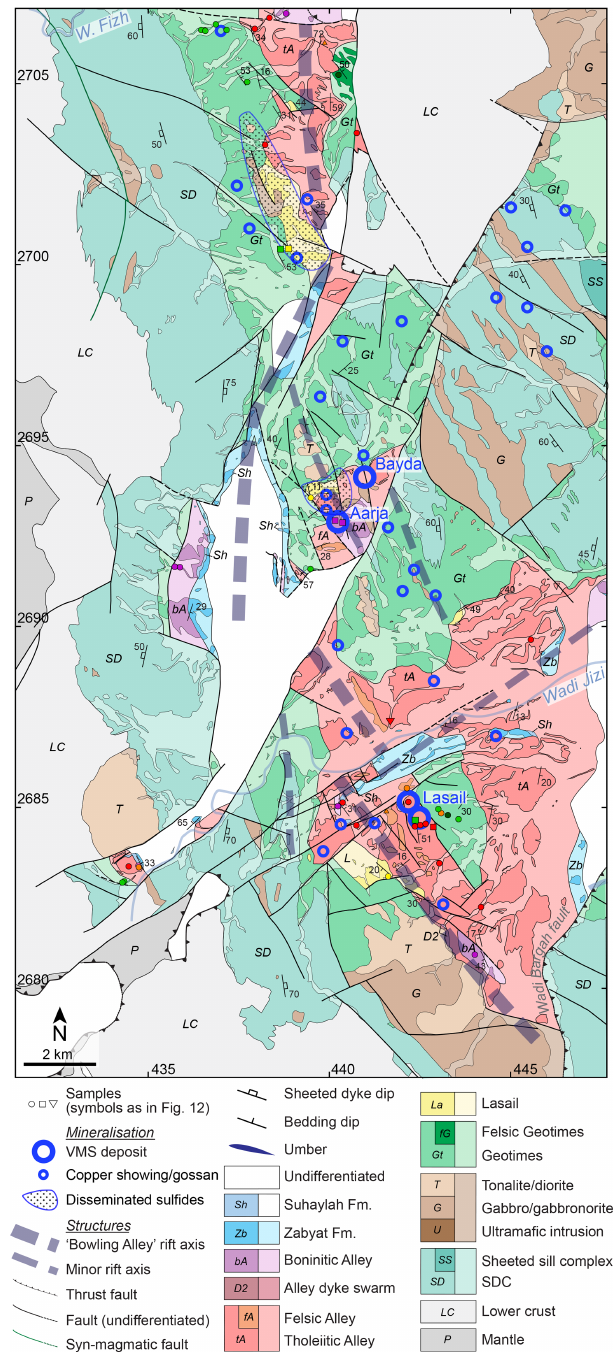
Figure 17. Interpreted location of the “Bowling Alley” rift, mod- ified after Alabaster and Pearce (1985), BME (1987a), Robertson and Woodcock (1983), and Smewing et al. (1977). The rift is ge- netically associated with numerous VMS deposits, minor copper showings and areas of disseminated sulfide mineralisation (Haymon et al., 1989; Smewing et al.,